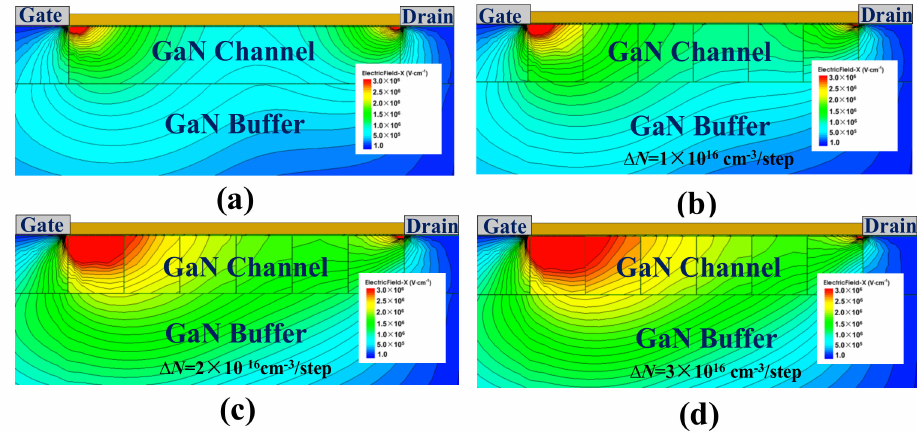
Figure 8. The 2–D E–field distributions of ( a ) the conventional HEMT and ( b – d ) the SDC–HEMTs with different doping gradients.